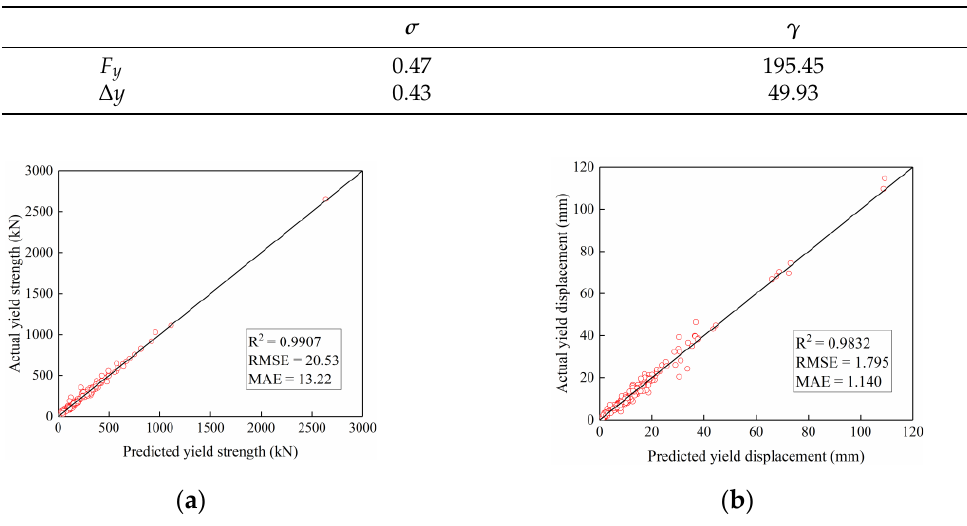
Table 3. Obtained optimal parameters of LSSVM by PSO.